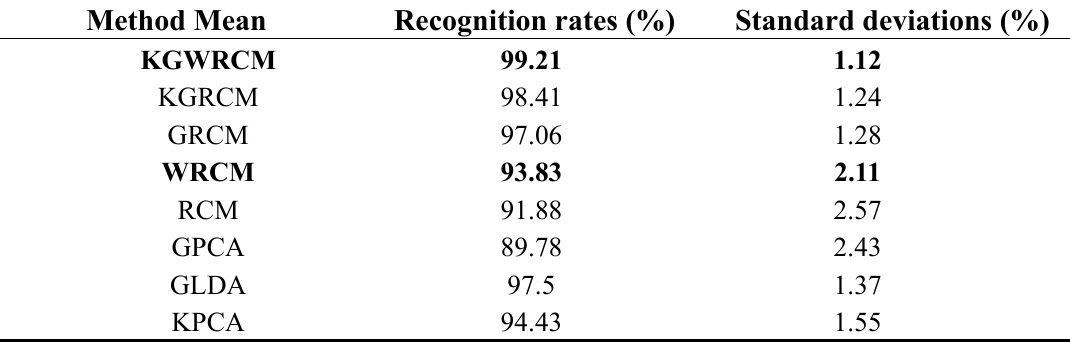
Table 1. The performance of different approaches on the ORL face database.